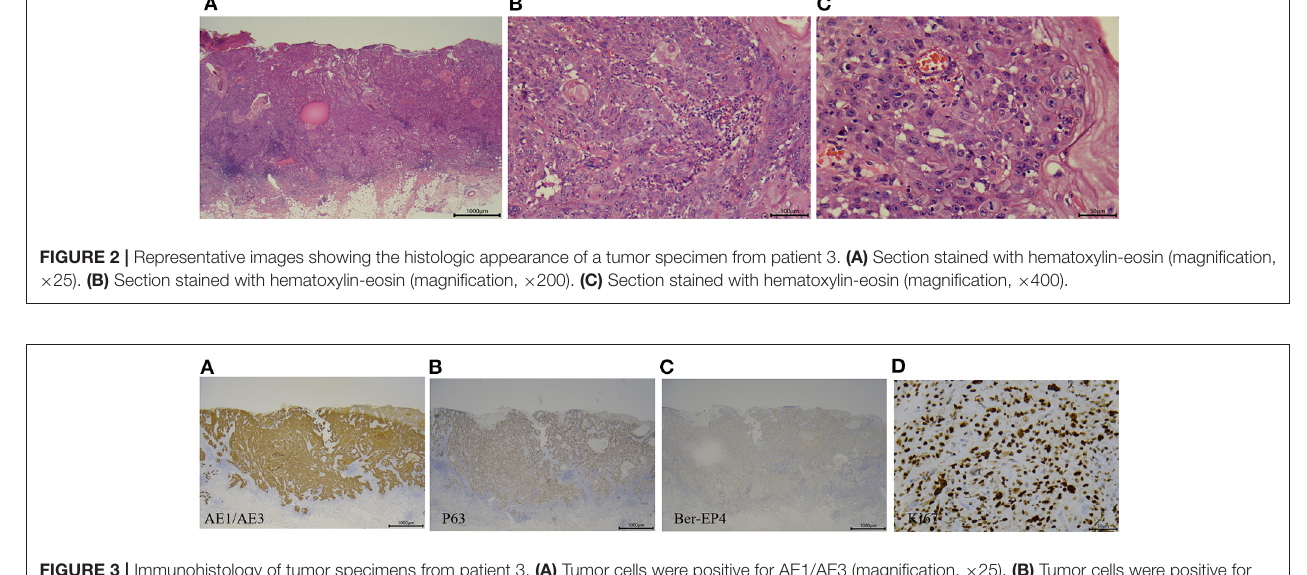
( Figure 1B ). Skin biopsy confirmed the diagnosis of